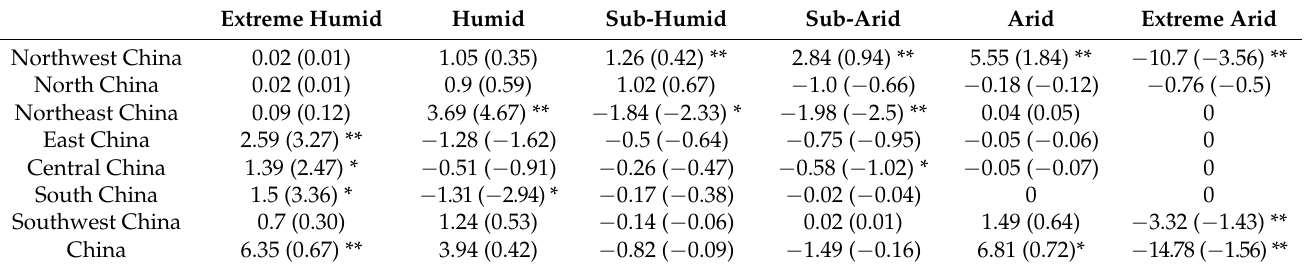
Table 5. The linear trends of the areas of different climate zones and proportions to the whole area of China in different regions from 1961 to 2020 (unit: Km 2 (%)/10